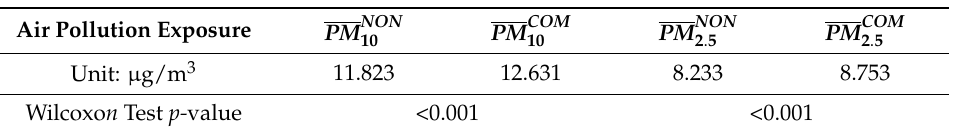
Table 4. Means of instantaneous exposure to PM 10 and PM 2.5 for non-commuting and commuting cycling